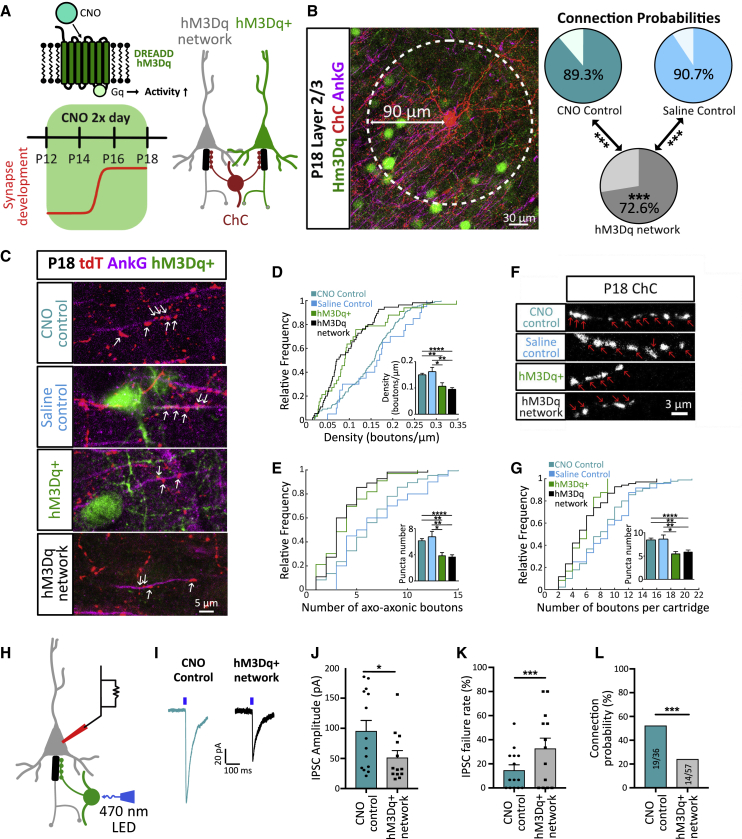
Activity-Dependent Plasticity of Axo-axonic Synapses(A) Schematic of DREADD receptor hM3Dq (top left), timeline of CNO application (below), and logic of experimental design resulting in ChCs contacting hM3Dq+ (green) and hM3Dq– (gray) pyramidal cells in the same network.(B) Connection probability of ChCs at P18 in a 90 μm radius (white circle) following injection of CNO into control mice (CNO control), into hM3Dq expressing mice (hM3Dq network) or saline into hM3Dq expressing mice (saline control) (chi-square test. n = 270–390 cells, 3–4 mice, per condition).(C) Example images showing axo-axonic boutons overlapping with the AIS at P18.(D and E) Cumulative distribution of and average axo-axonic bouton density (D) and number (E) (one-way Kruskal-Wallis with Dunn’s multiple comparison test. n = 20–132 cells, 3–4 mice, per condition).(F) Example images of axo-axonic cartridges.(G) Cumulative distribution and average cartridge size (Kruskal-Wallis with Dunn’s multiple comparison test, n = 21–40 neurons, 3–4 mice, per condition).(H and I) Schematic diagram of patch-clamp experiment (H) and representative GABAergic PSCs (I) from pyramidal cells after optogenetic ChC stimulation for CNO control (blue) and hM3Dq-network (black) conditions.(J and K) Average GABAergic PSC amplitudes (J) and average failure rates (K) (chi-square test, n = 13–14 neurons, 4 mice, per condition).(L) Connection probability (chi-square test, n = 36–57 neurons, 5 mice, per condition). ∗p < 0.05 ∗∗∗p < 0.001. Bar plots show mean ± SEM.See also Figures S2, S3, and S5.